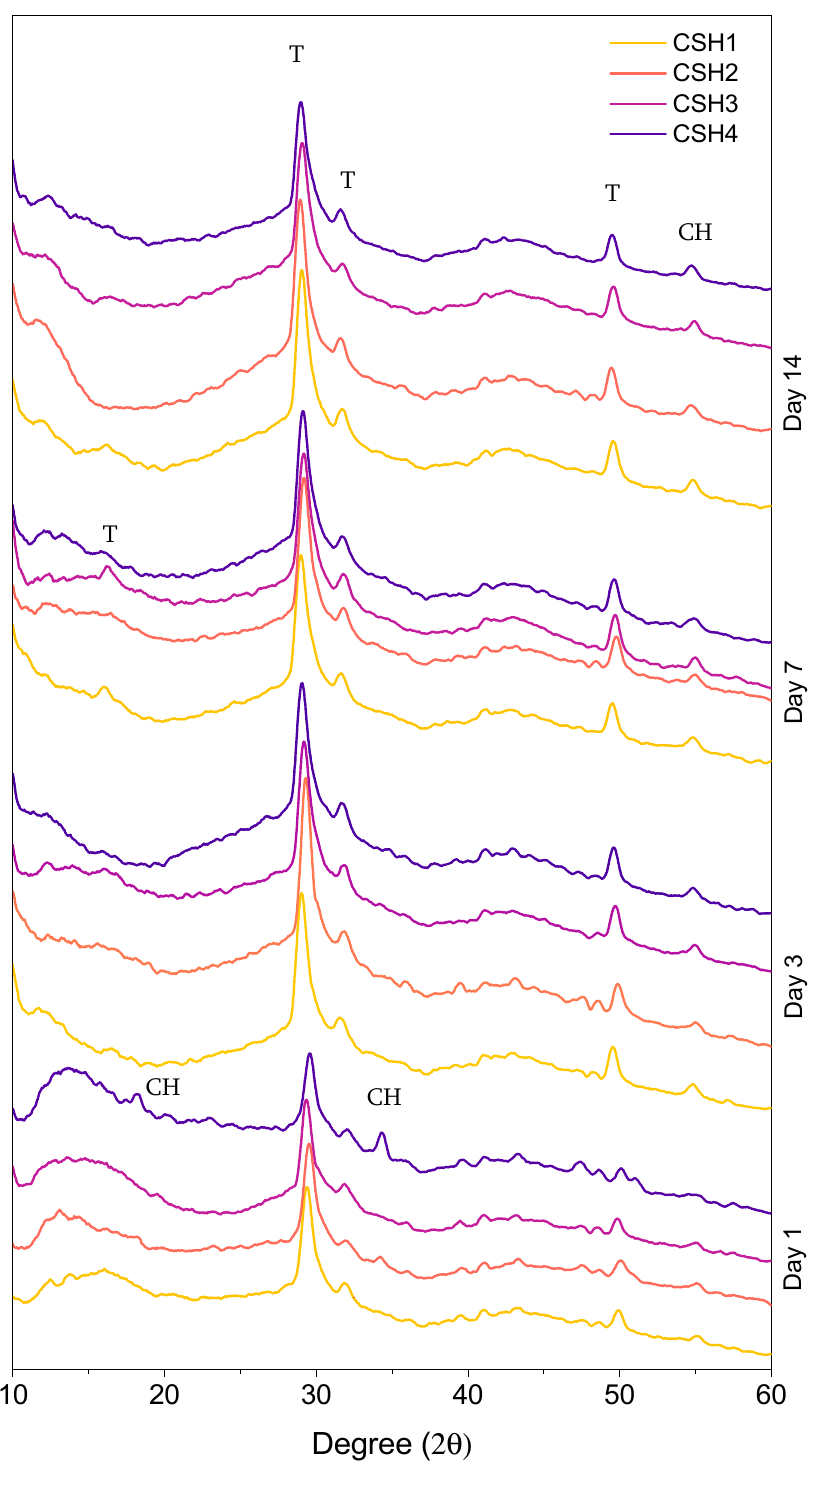
Figure 7. XRD pattern of different CSH gels after 1, 3, 7 and 14 days.